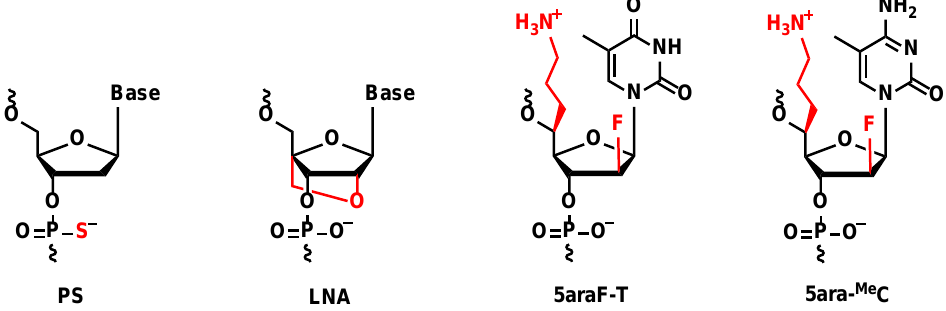
Figure 1. Chemical structure of phosphorothioate (PS), locked nucleic acid (LNA), ( S )-5 (cid:48) - C -aminopropyl-2 (cid:48) -arabinofluoro-thymidine ( 5ara-T ), and ( S )-5 (cid:48) - C -aminopropyl-2 (cid:48) -arabinofluoro-5- methyl-cytidine ( 5ara- Me C